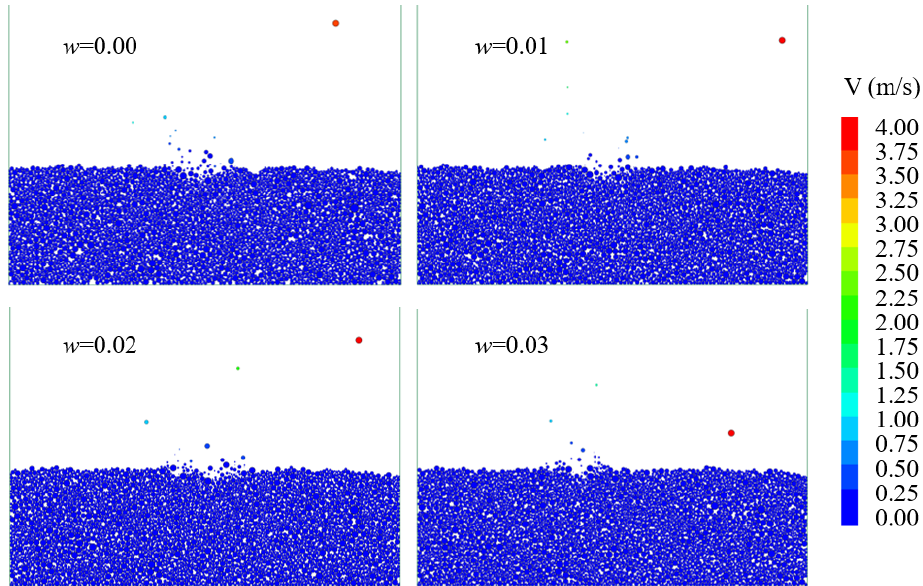
Figure 4. The motion behaviours of sand grains in sand-bed collision under different surface moisture in times of 0.15 s ( V in = 5m/s). Each circle represents a grain of sand and the colour indicates grain